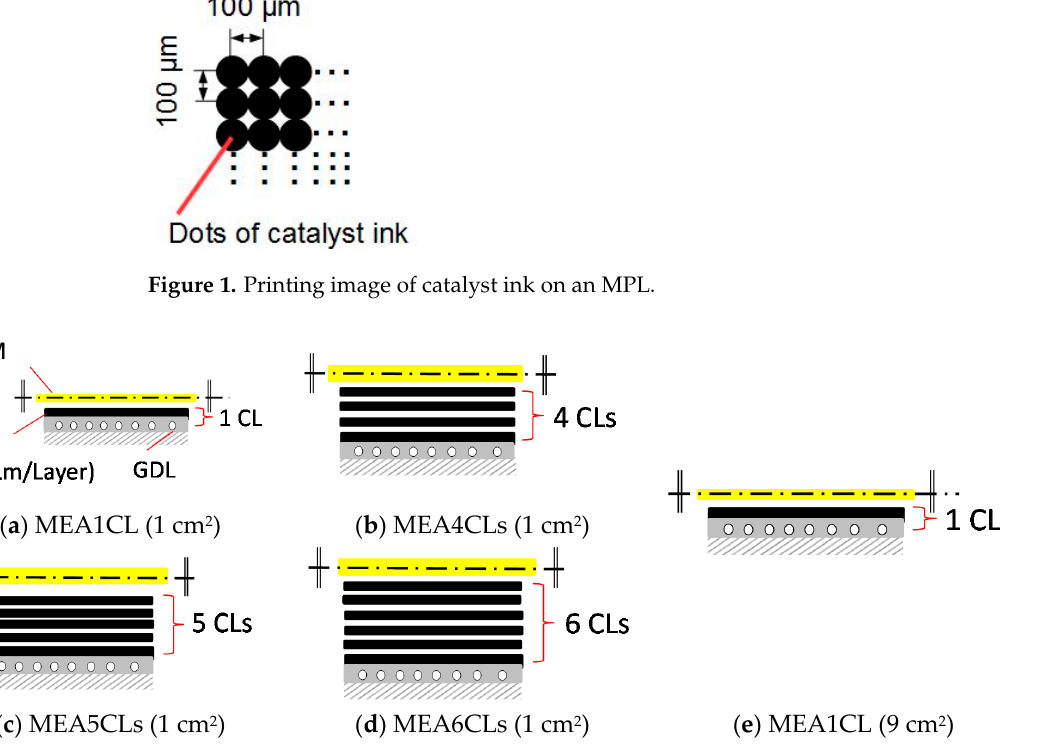
Figure 2. Schematic diagrams of the structure of MEA; ( a ) one CL and 1cm 2 of electrode area, ( b ) four CLs and 1cm 2 of electrode area, ( c ) five CLs and 1cm 2 of electrode area, ( d ) six CLs and 1cm 2 of electrode area, ( e ) one CL and 9cm 2 of electrode area.